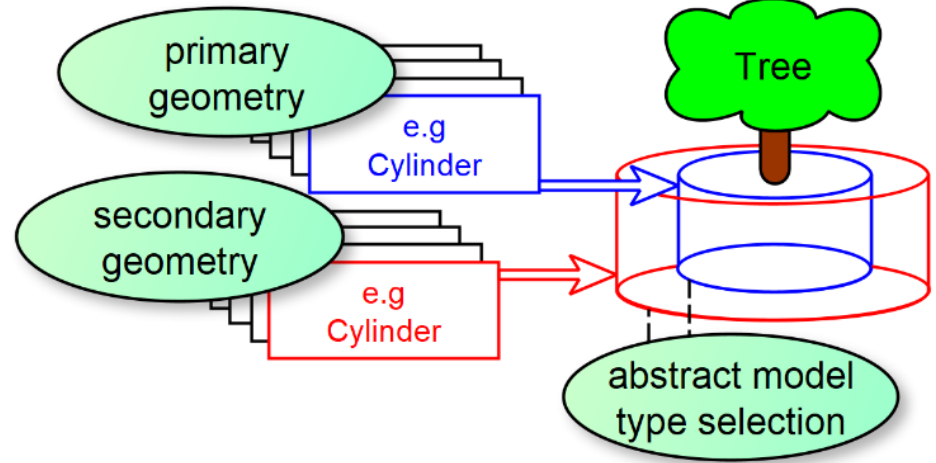
Figure 6. Geometry model selection for the tree root object-class in the taxonomy.